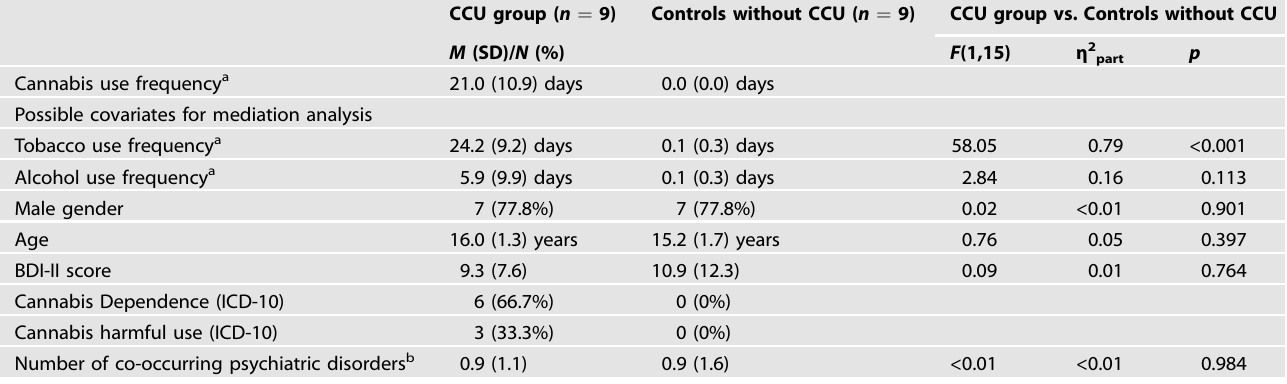
Table 1. Characteristics of demographics, substance use and comorbid disorders of the